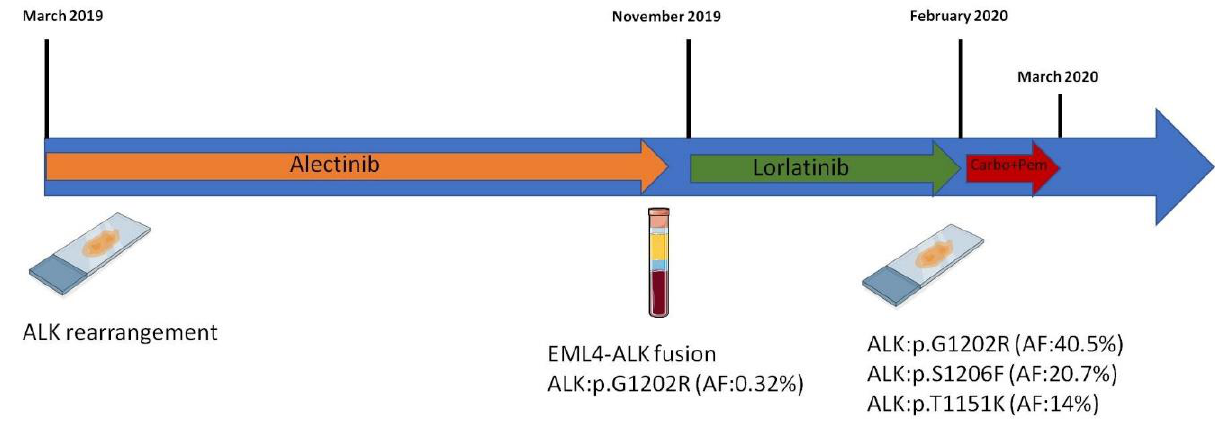
Figure 1. Timeline of the reported case.